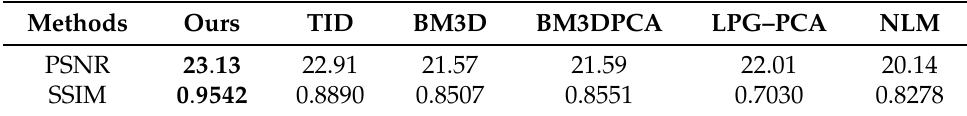
Table 1. Comparison of the average PSNR and SSIM between the proposed method and other existing methods.